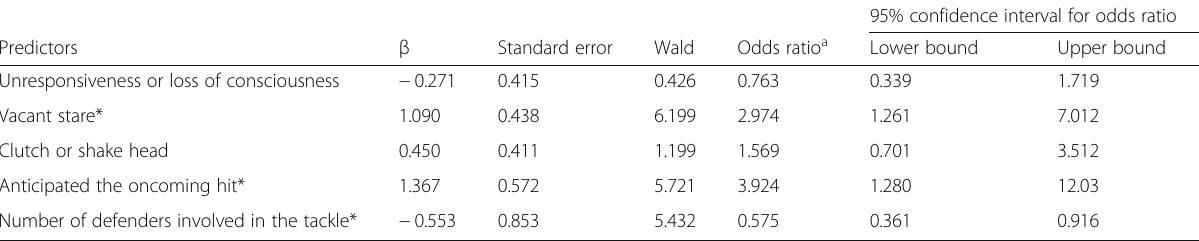
Table 5 Results for the multivariable logistic regression analysis of the characteristics independently associated with a subsequent diagnosis of